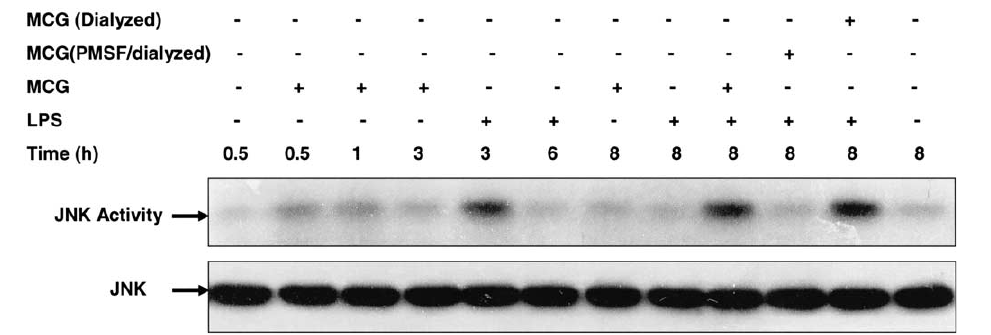
FIG. 3. Kinetics of JNK activation in HUVECs after stimulation with MCG and LPS. Confluent HUVECs (5 (cid:5) / 10 6 ) were stimulated with MCG, dialyzed MCG or dialyzed PMSF-treated MCG (2.5 (cid:5) / 10 6 mast cell equivalents) alone or in a combination with LPS. Cell lysates were prepared after the indicated time intervals. Immune complex kinase assays were performed as described in Materials and methods using GST-c-Jun as a substrate for JNK. Protein loads were monitored by western blot using anti- JNK1 antibody. Similar results were noted in two additional experiments.